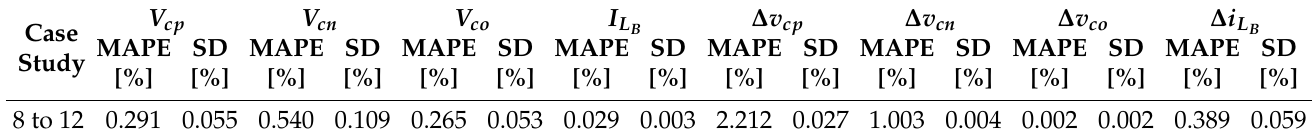
Table 8. Percentage error statistical results of the proposed converter with an input voltage variation. Case